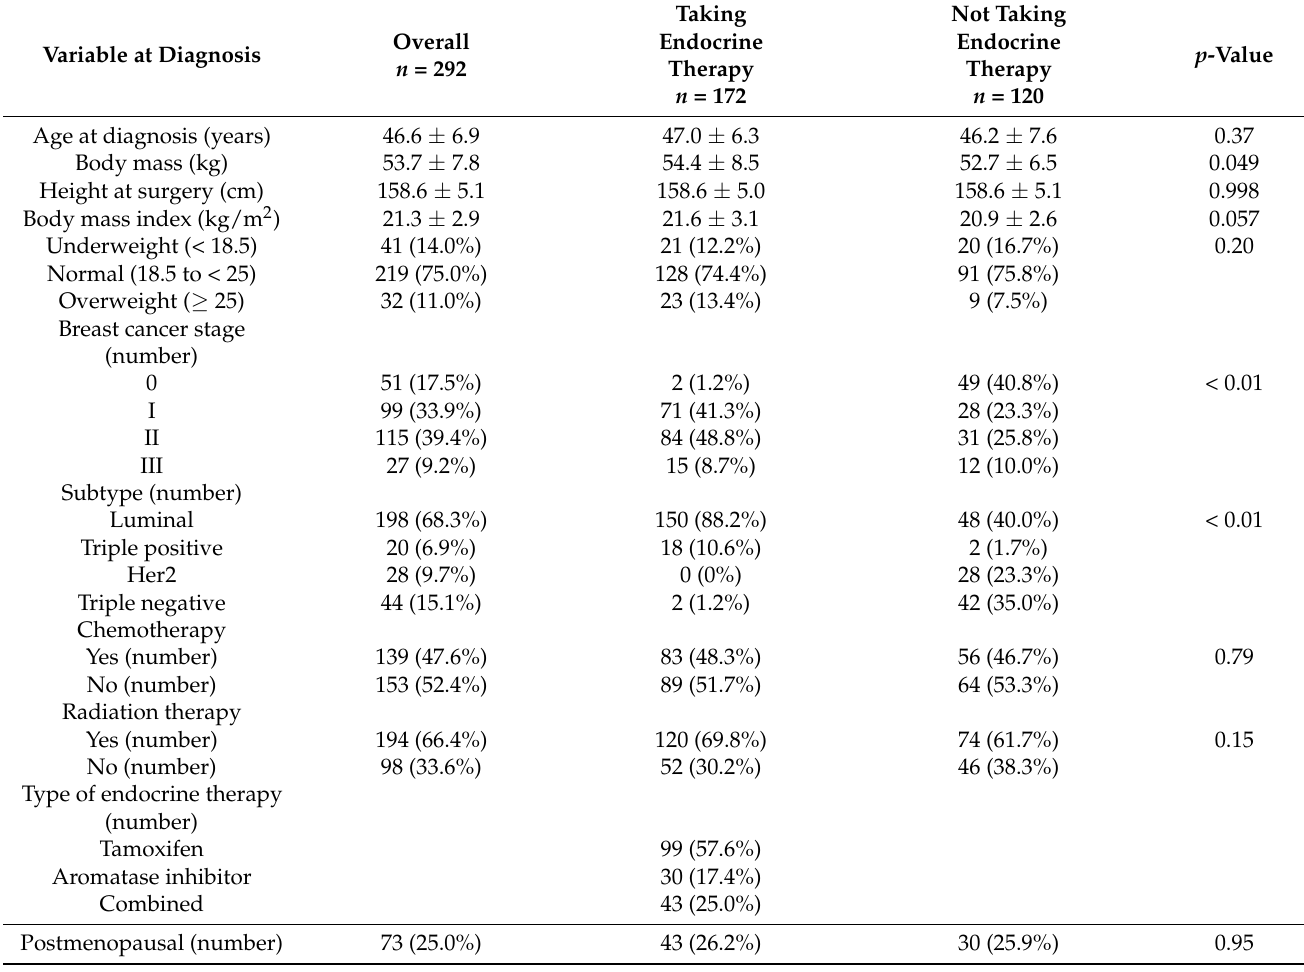
Table 1. Patient characteristics at the diagnosis of breast